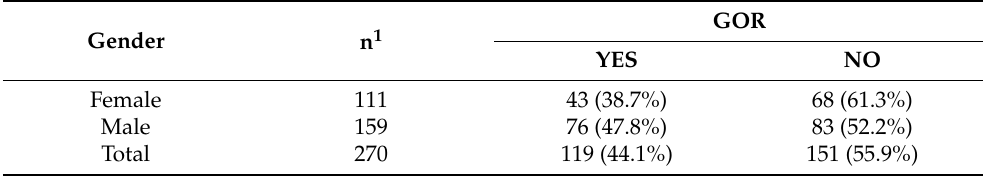
Table 3. The incidence of GOR between genders in dogs submitted to esophageal pH-measurement during anesthesia for non-intrabdominal, non-intrathoracic procedures.